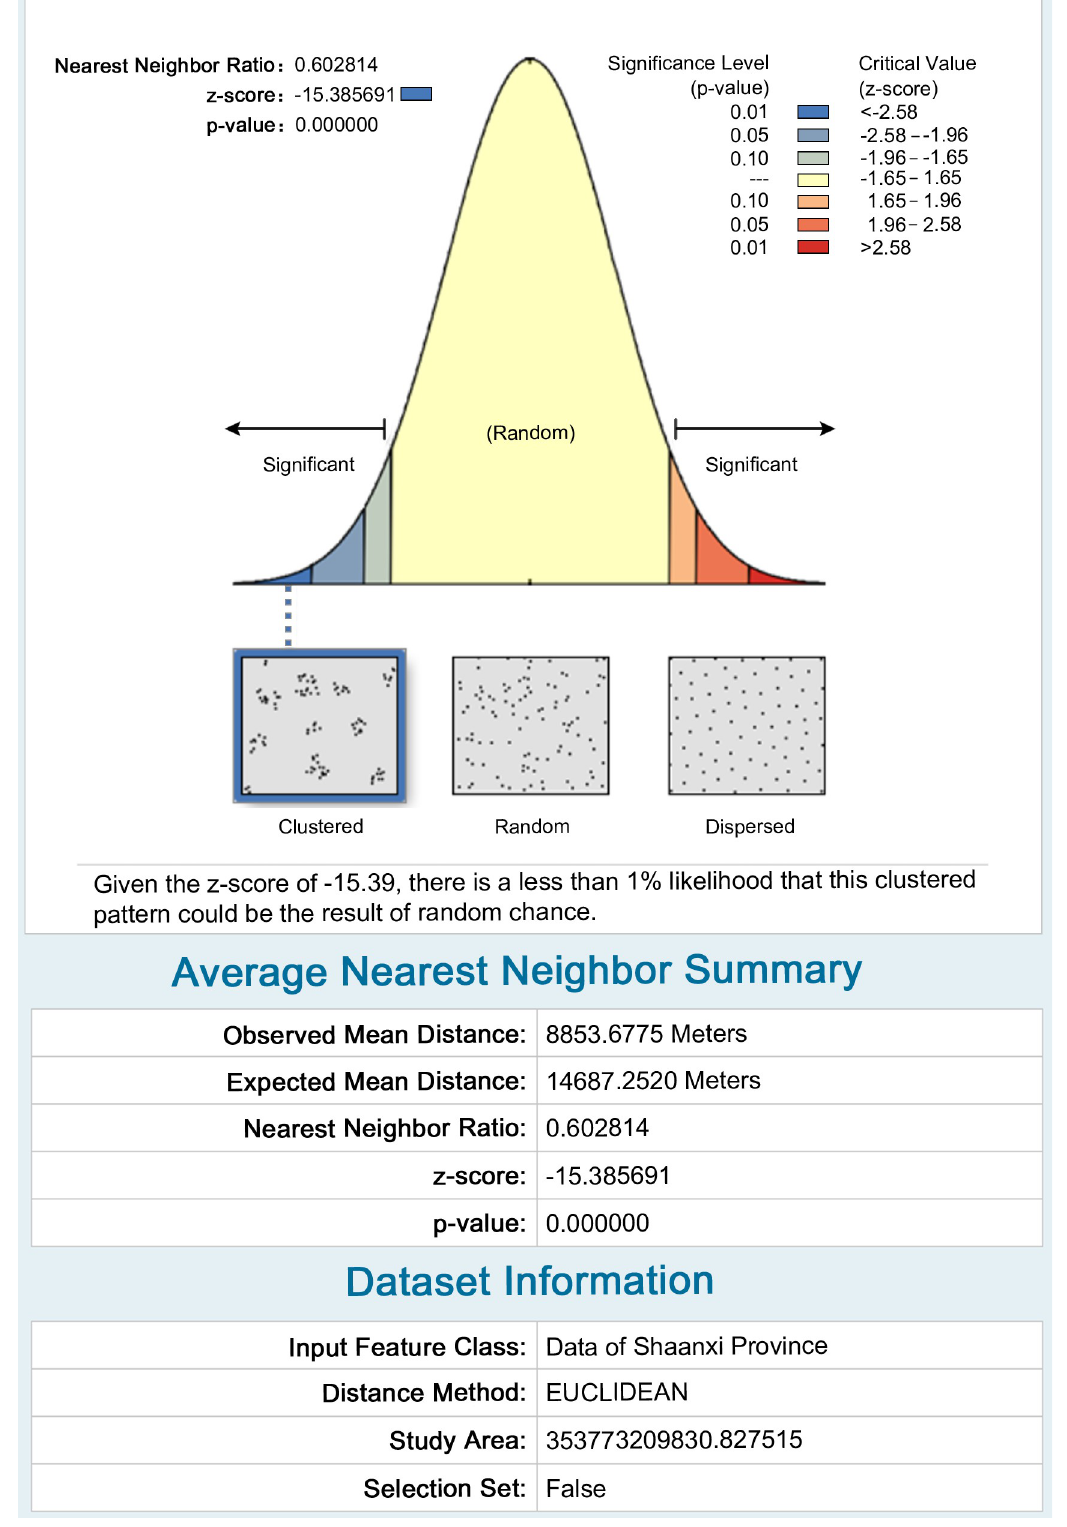
Fig 5. Nearest neighbor index analysis